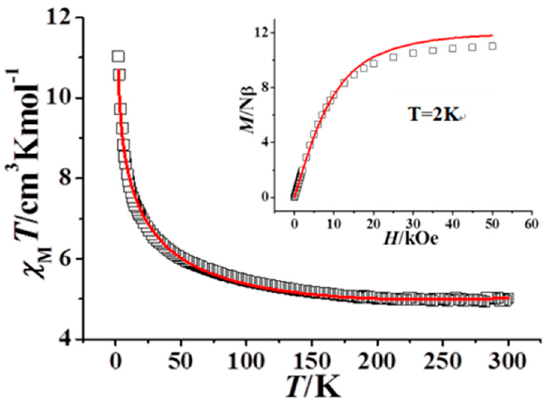
Figure 3. χ M T vs. T and ( insert ) M vs. H behaviors for complex 1 . The red line is the best fit (see text).